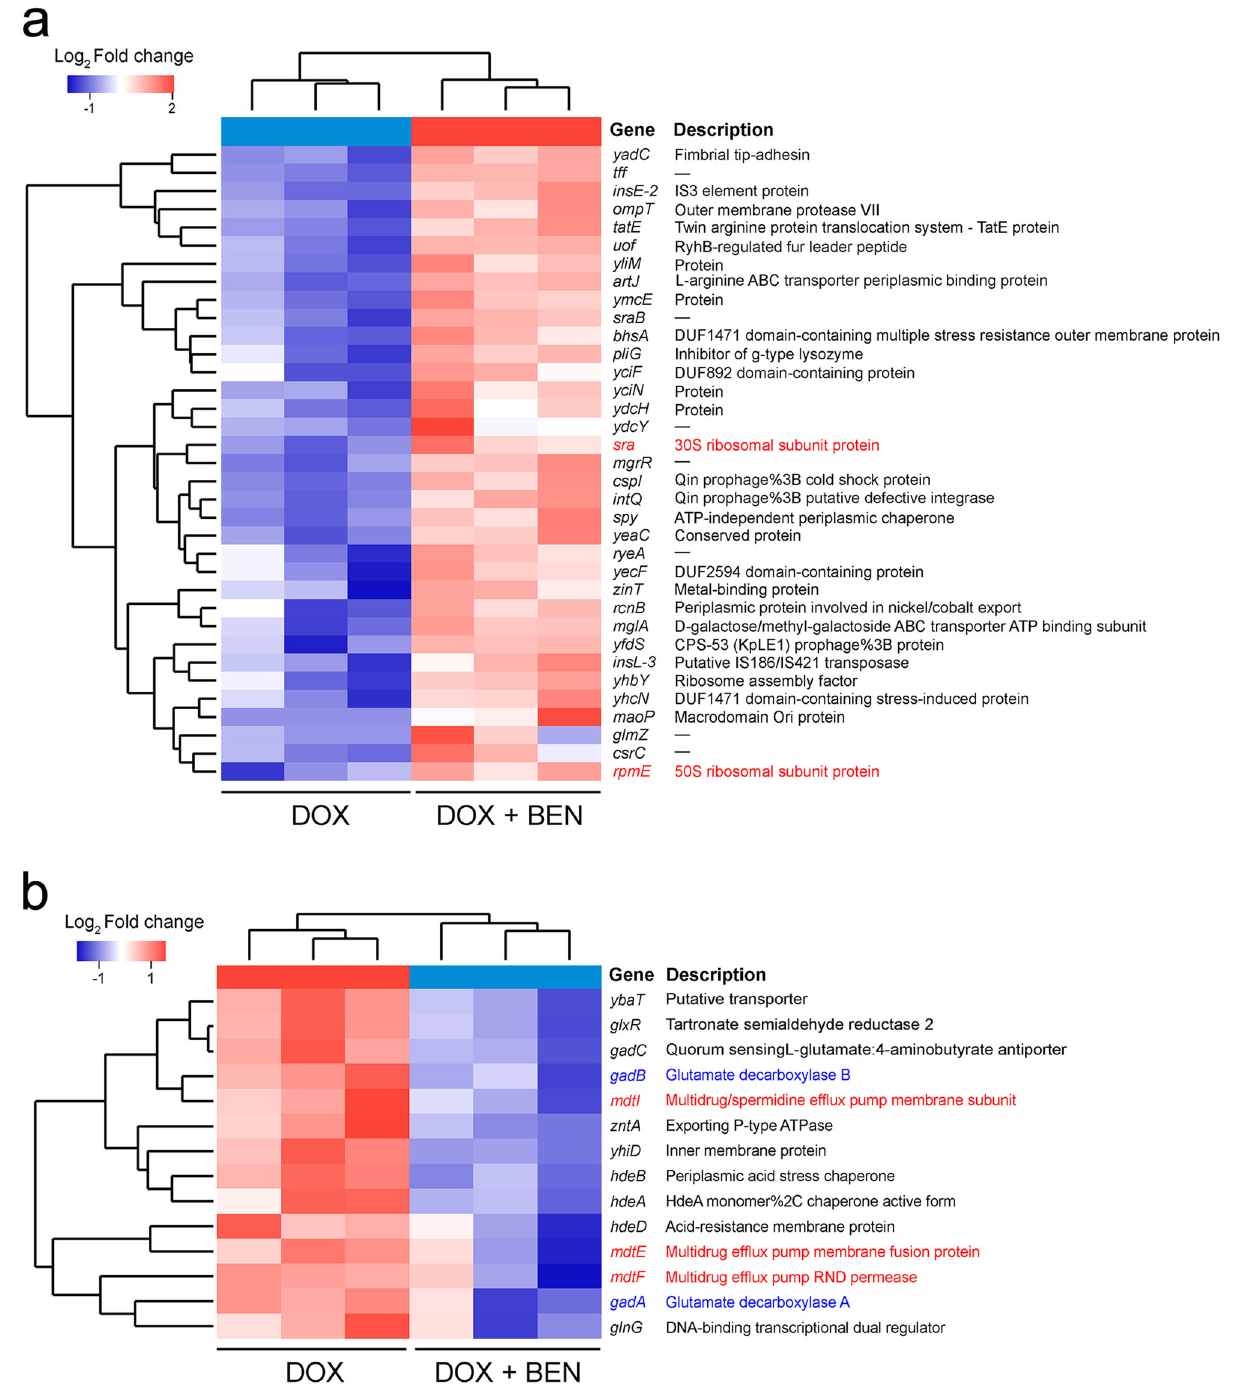
Fig. 5 Differentially expressed genes (DEGs) of E. coli B2 after treatment with doxycycline plus benzydamine in comparison to doxycycline alone. Signi fi cant upregulated ( a , P < 0.05, Log2Fold change ≥ 1) and downregulated DEGs ( b , P < 0.05, Log2Fold change ≤ − 1) in combination treatment group compared with doxycycline